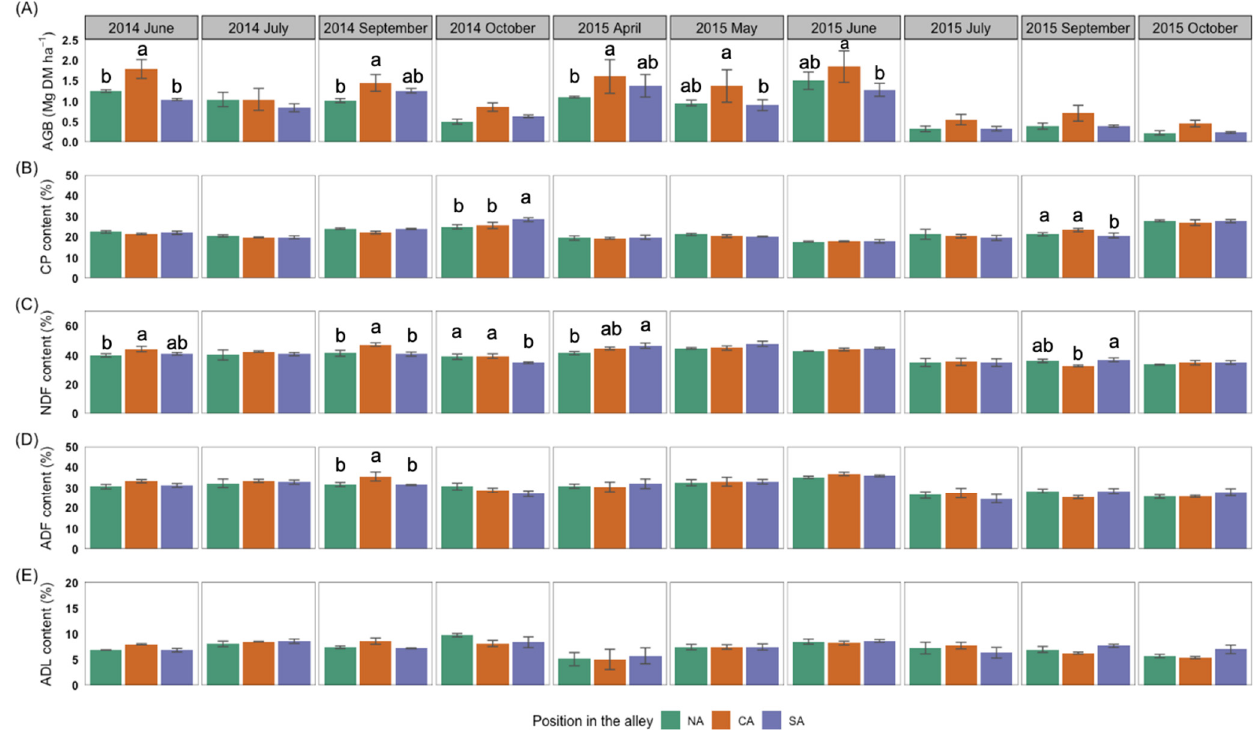
Figure 3. Average value of: ( A ) alley-cropping alfalfa above-ground biomass (AGB), ( B ) crude protein (CP), ( C ) neutral detergent fibre (NDF), ( D ) acid detergent fibre (ADF), and ( E ) acid detergent lignin (ADL) content per harvest time (from June 2014 to October 2015) of investigated position in the alley: north-facing side (NA), central part (CA) and south-facing side (SA). Vertical bars indicate standard error of the mean. Same letters indicate that treatments are not different at the 0.05 probability level according to Tukey’s HSD Test.